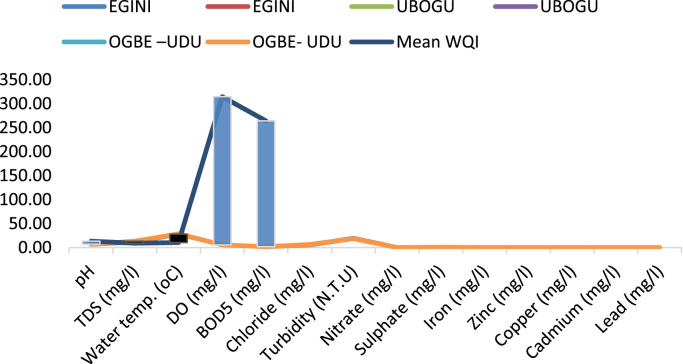
Relationship between WQI and the Physical and chemical parameters at Egini, Ugbogu and Ogbe-Udu, Rivers Delta state.